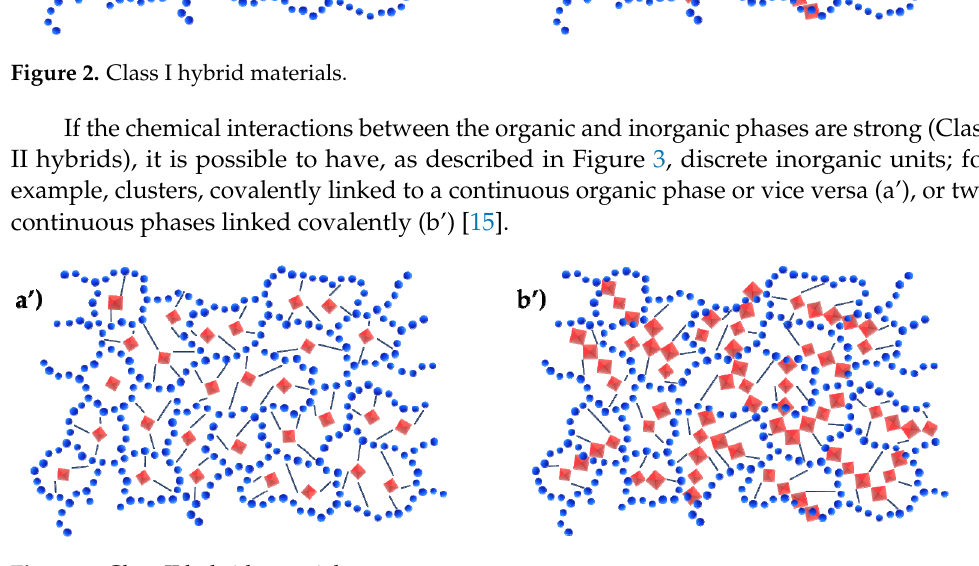
Figure 3. Class II hybrid materials.